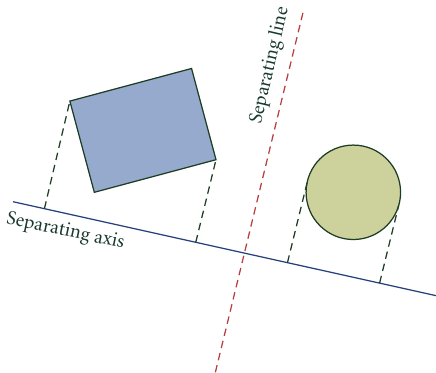
Figure 3: Illustration of the separating axis theorem.